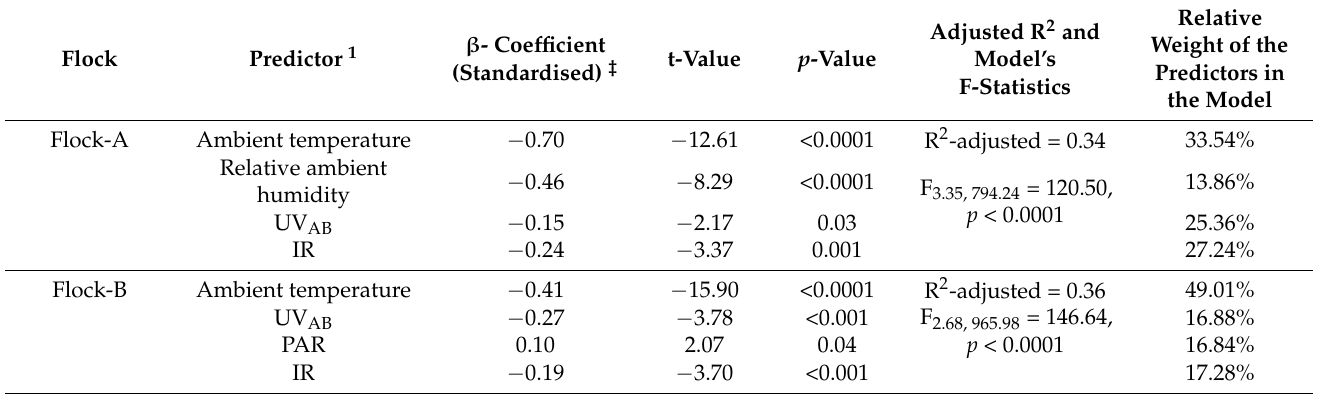
Table 1. Two ridge regression analyses (ridge parameter, k = 0.02) on the number of hens under the shelter throughout the day. Only variables that significantly contributed to the most parsimonious model are presented.